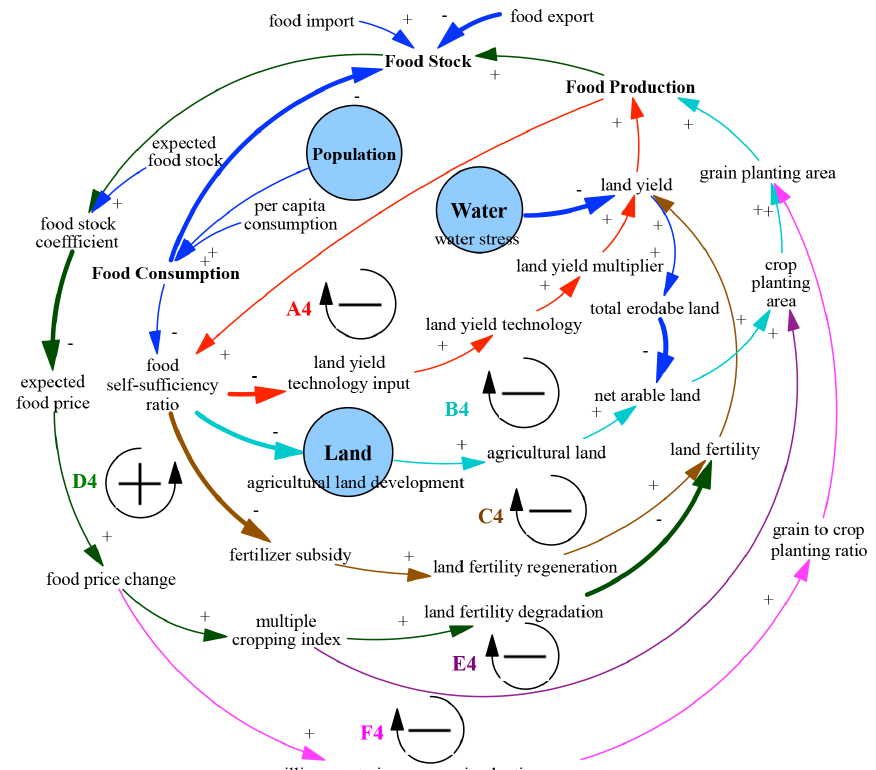
Figure 6. CLD in the food sector.